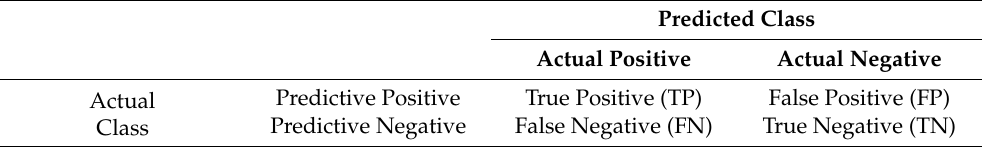
Table 2. Confusion matrix for two